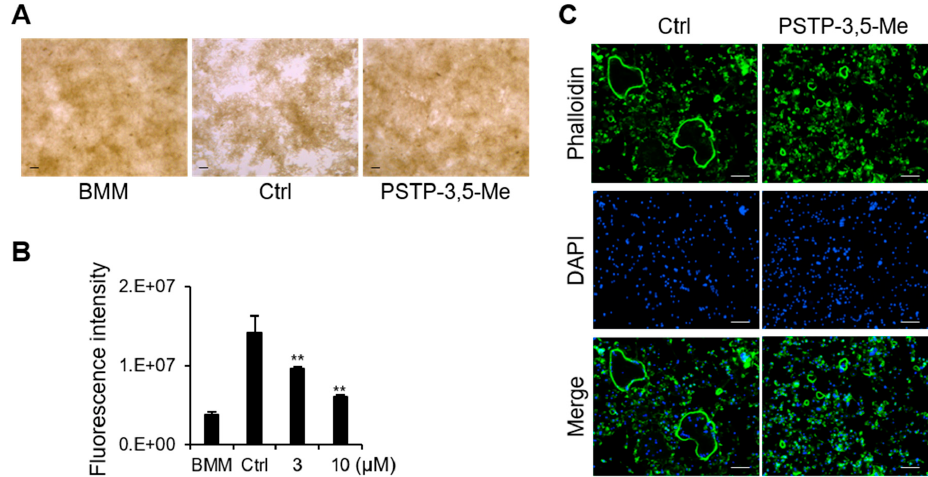
Figure 5. Osteoclast activity was inhibited by PSTP-3,5-Me. ( A ) Bone resorption assay was performed on BMMs with vehicle (Ctrl) or PSTP-3,5-Me treatment. The resorption pit area is indicated as white empty spaces in the picture. ( B ) Fluorescence intensity represented resorption activity in the presence of RANKL and 0, 3, or 10 µM PSTP-3,5-Me; n = 3. BMM is osteoclast precursor cells cultured in only M-CSF. ** p -value < 0.01 is considered statistically significant compared to the Ctrl. ( C ) Actin-ring formation was determined by phalloidin antibody in the vehicle (Ctrl)- or PSTP-3,5-Me- treated BMMs by RANKL stimulation.